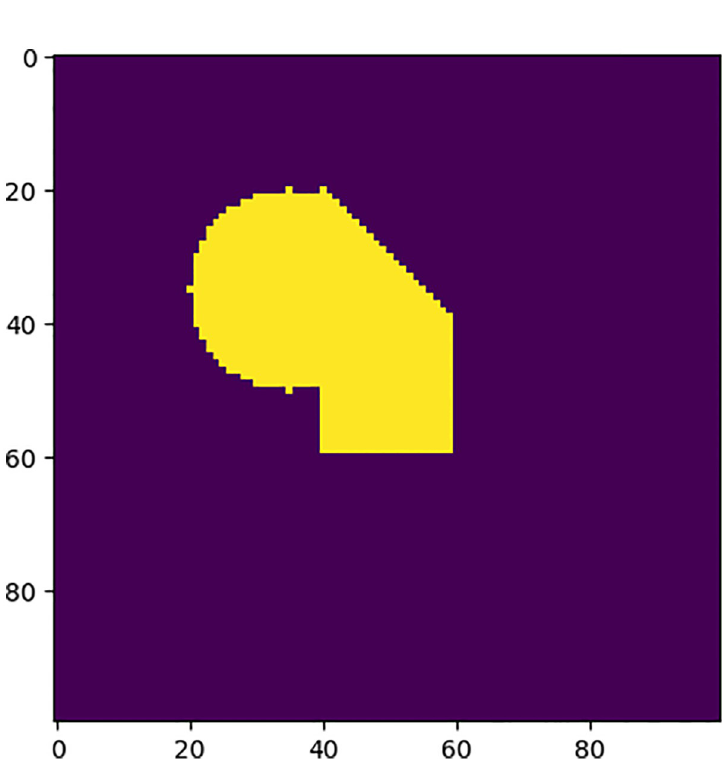
Fig 14. The non-empty bin. In the figure, the dark area is the part of the material that can be used, and the light part of the raw material is destroyed.